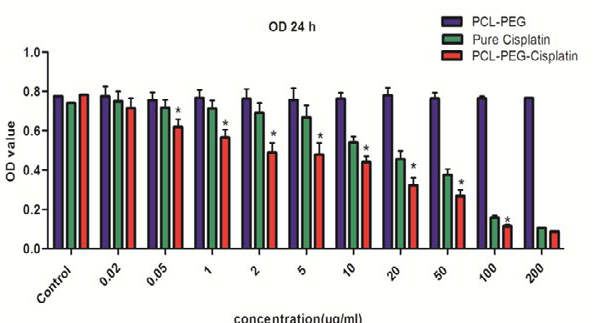
Fig. 5.a: The results of the treatment cells (A